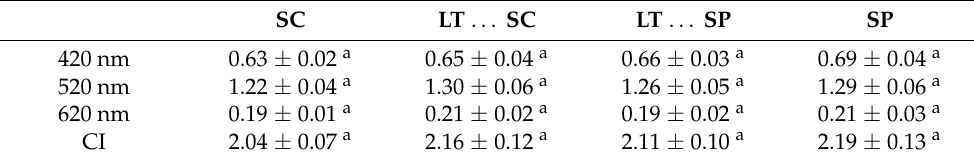
Results are mean ± SD of three replicates. Different letters indicate statistical significance between